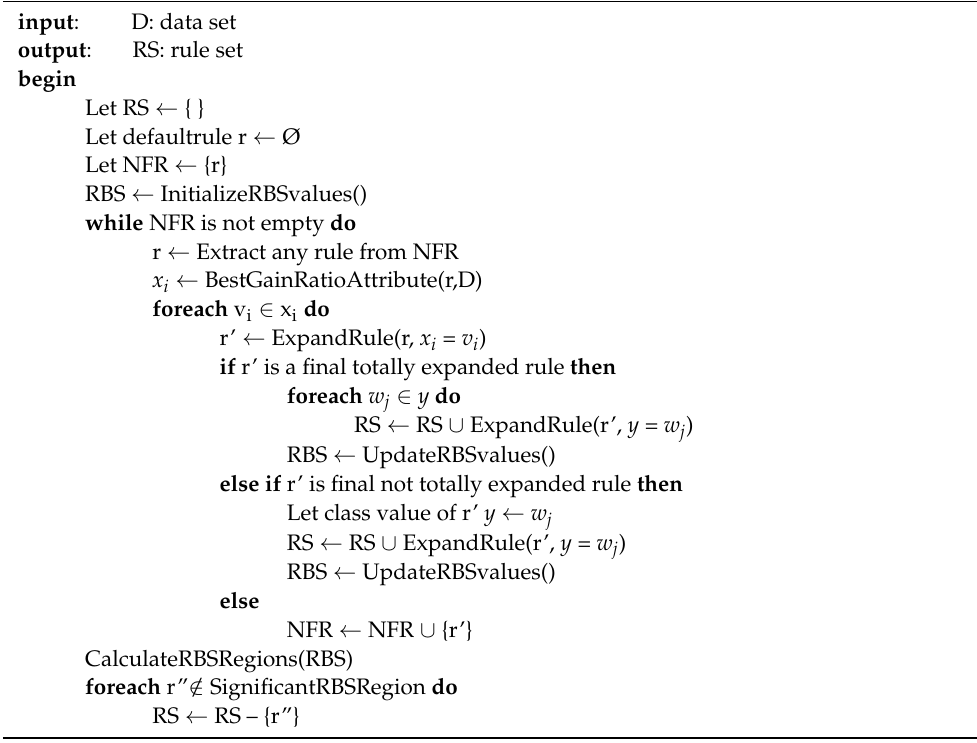
Algorithm 1: CREA: Classification Rule Extraction